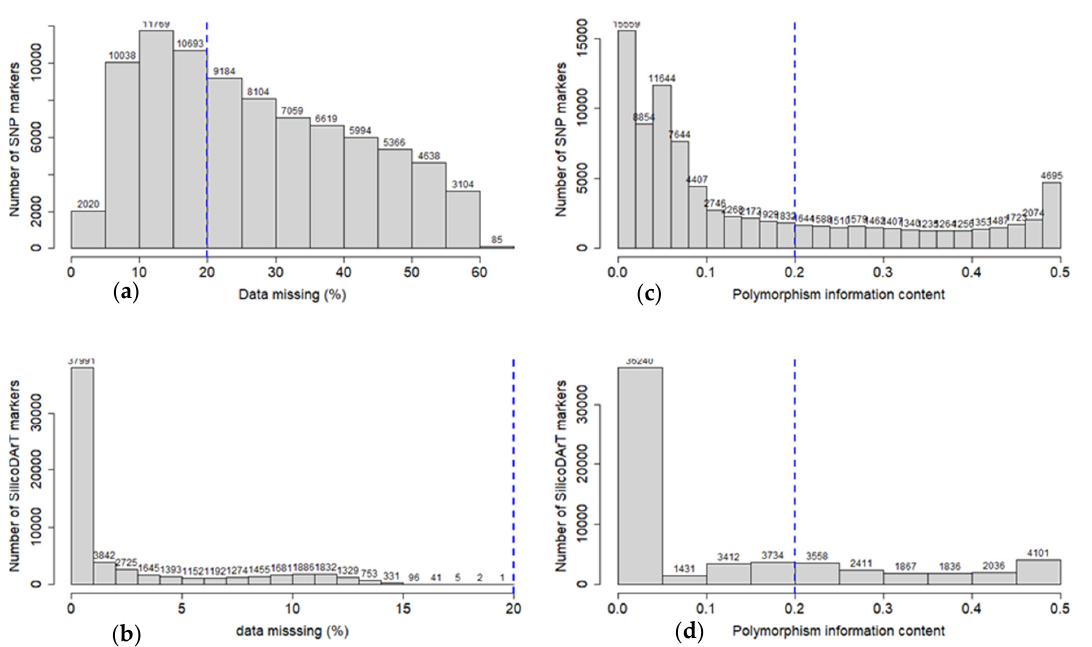
Figure 1. Number of DArTSeq markers by missing data (%) and PIC values for SNP ( a , c ) and SilicoDArT markers ( b , d ), respectively. The dotted blue vertical line indicated the threshold value for filtered markers.